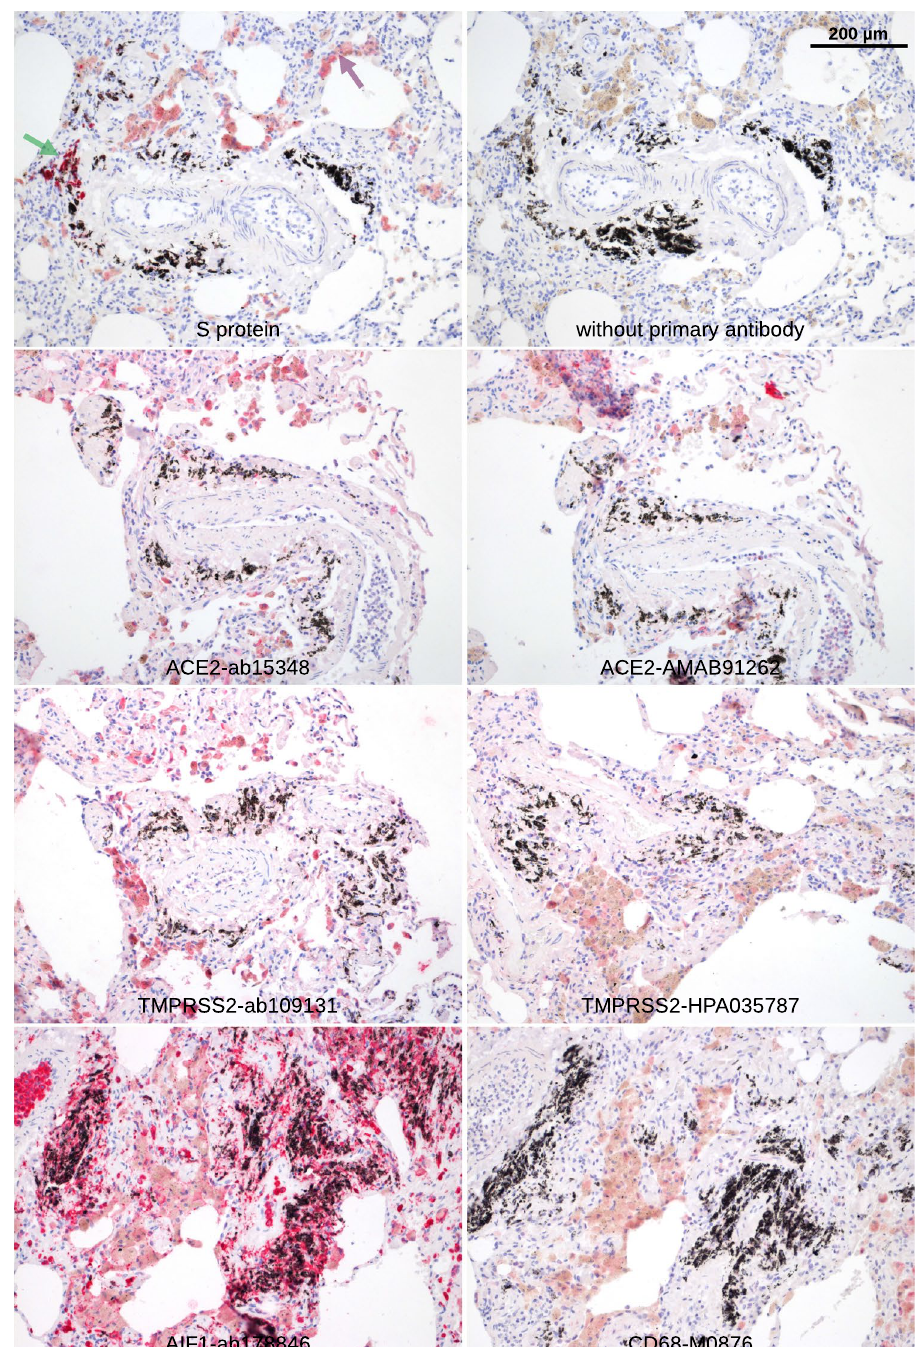
Figure 1. Lung. Paraffin sections of normal human lung were stained with S protein or different antibodies as indicated. Red staining was found in pigmented cells (macrophages that are positive for AIF1 and CD68, purple arrow) as well as cells at black material that are probably also a subtype of macrophages (green